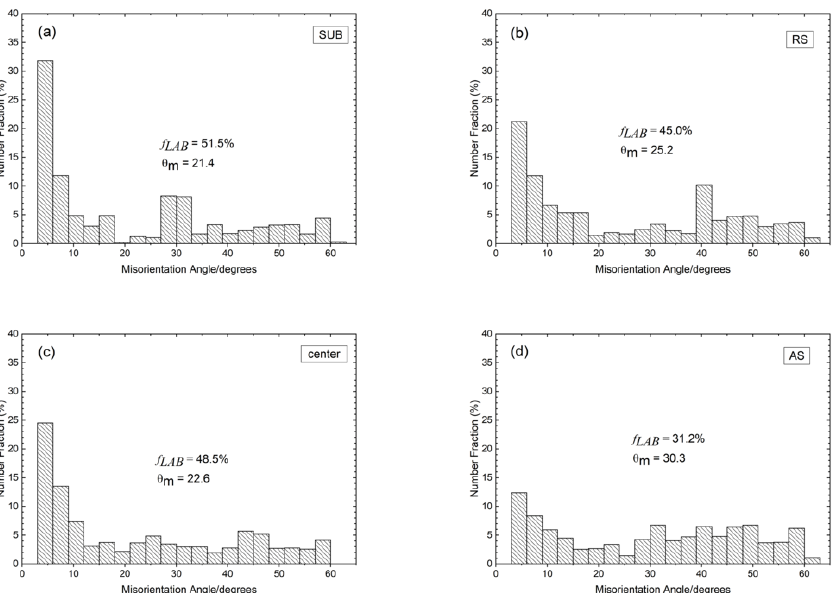
Figure 6. Misorientation angle histogram for α / α boundaries: ( a ) SUB, ( b ) RS, ( c ) center, and ( d ) AS.